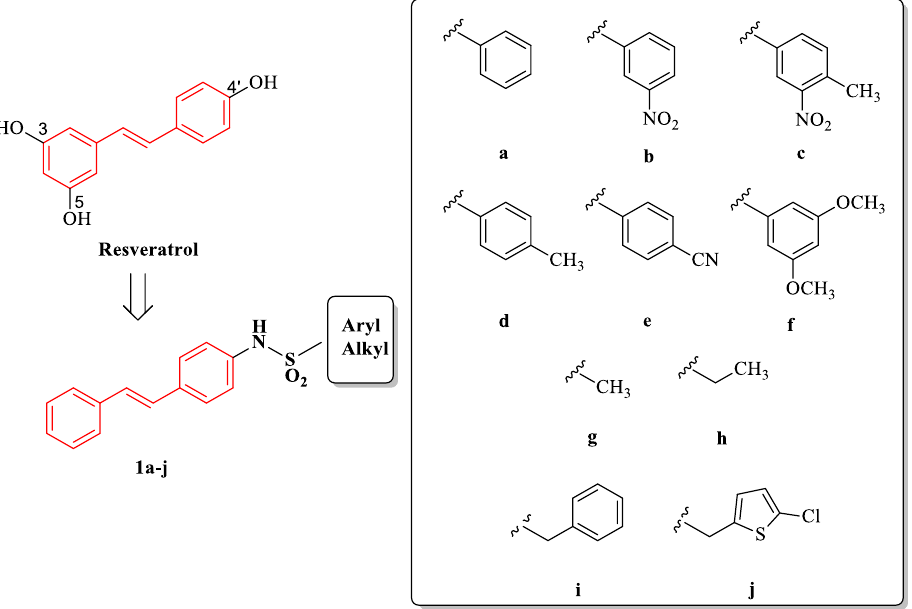
Figure 1. Structures of RSV and its derivatives 1a – j